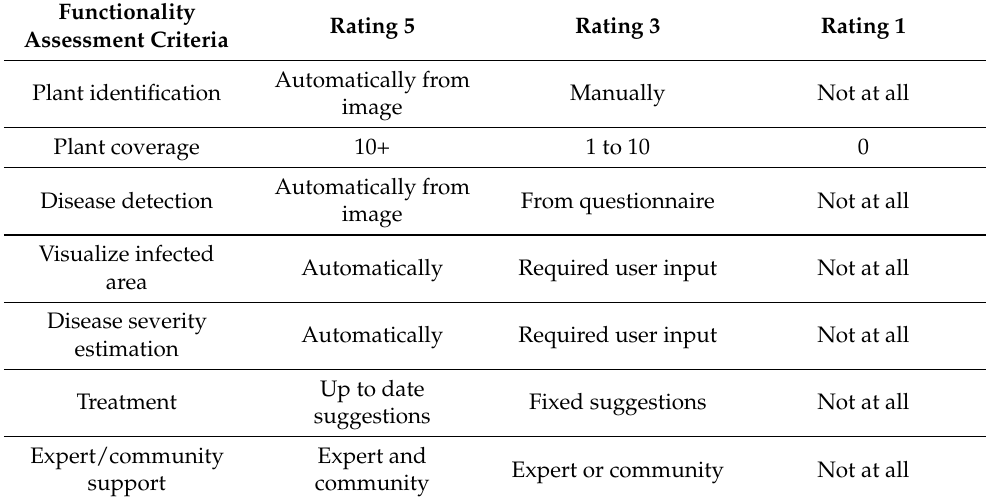
Table 2. Functionality assessment criteria